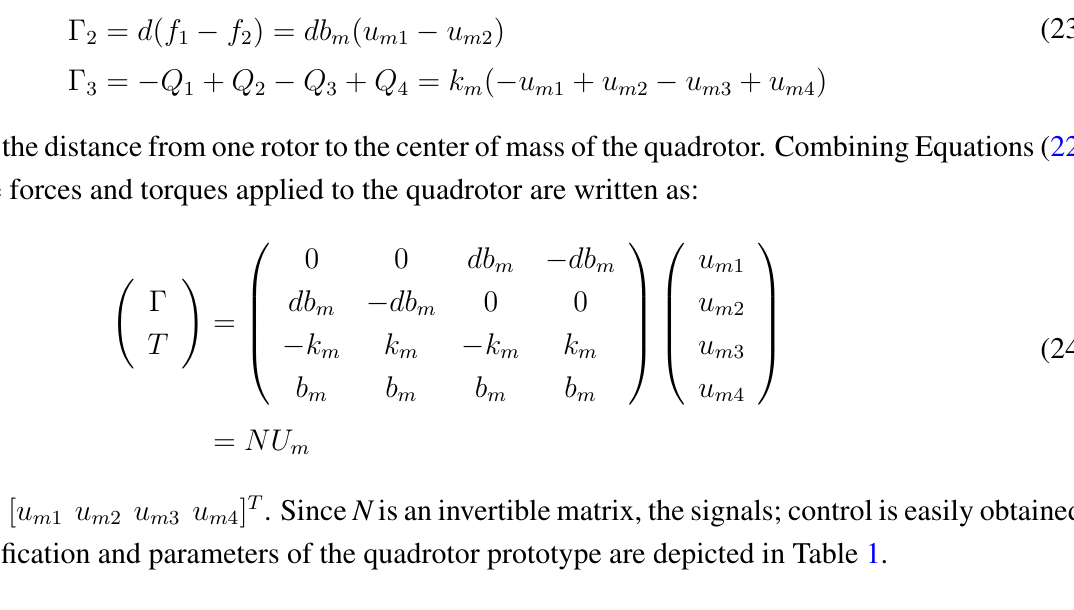
Table 1. The specification and parameters of the